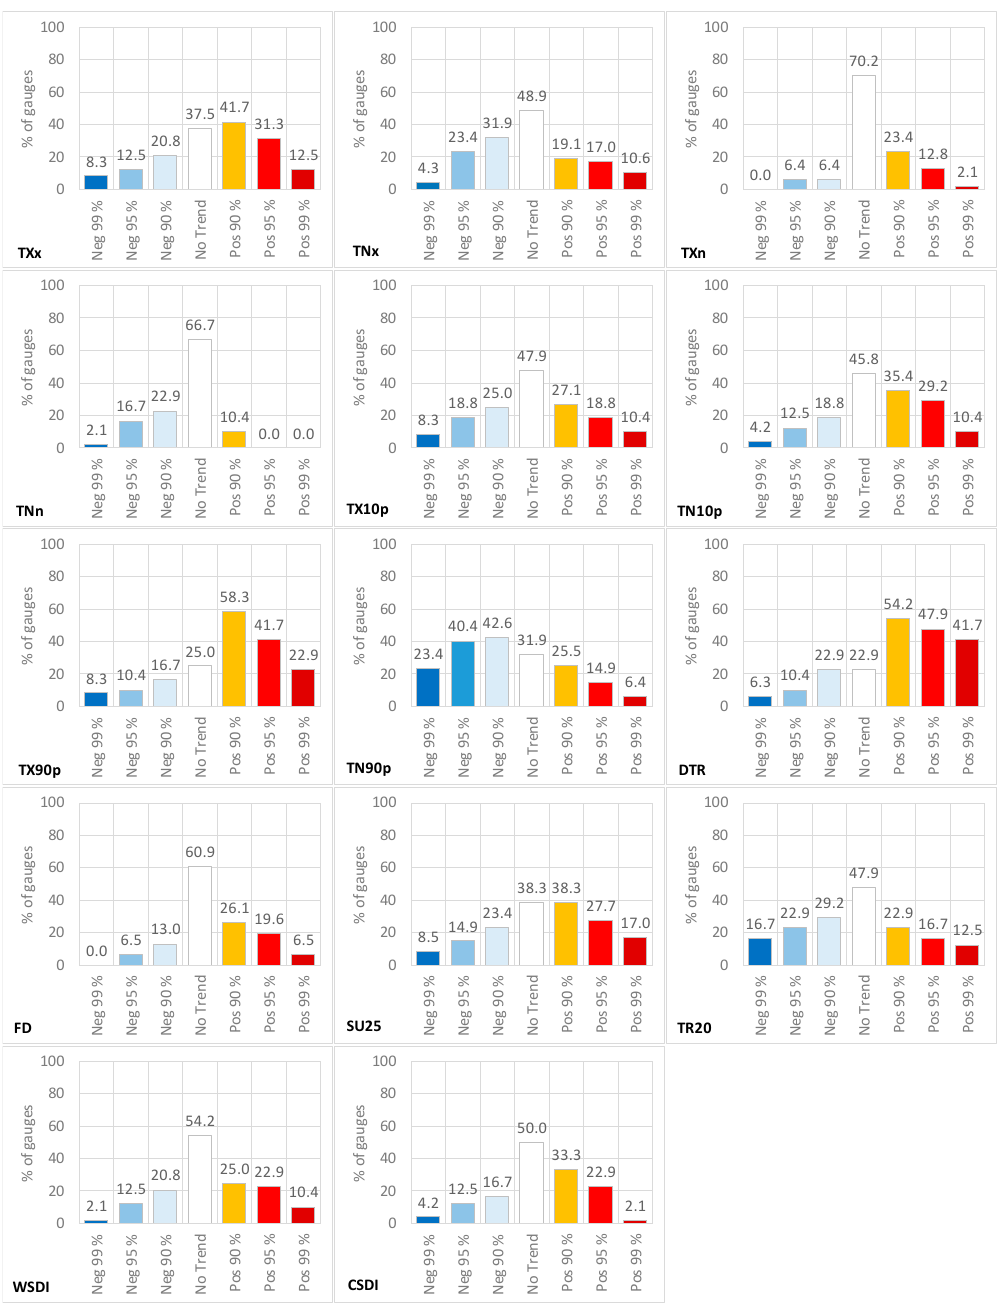
Figure 6. Percentages of extreme temperature indices series presenting positive or negative significant Figure6. trends.